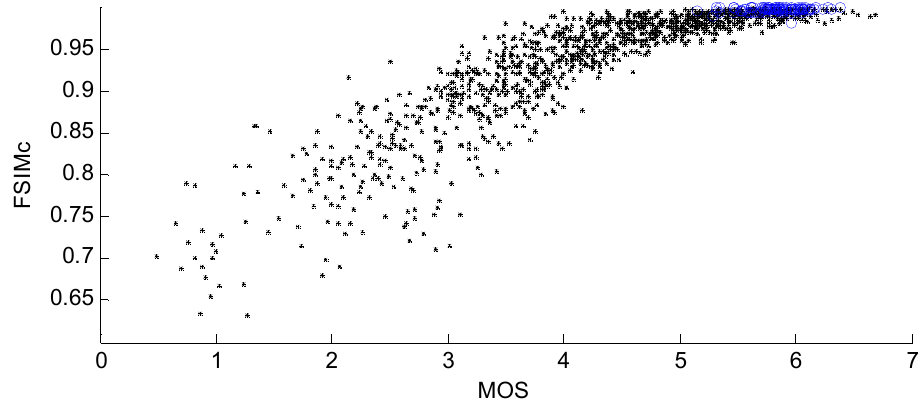
Figure 2. The scatter plot of color version of Feature SIMilarity (FSIMc) vs. MOS (blue circles correspond to images for which distortions have not been detected).